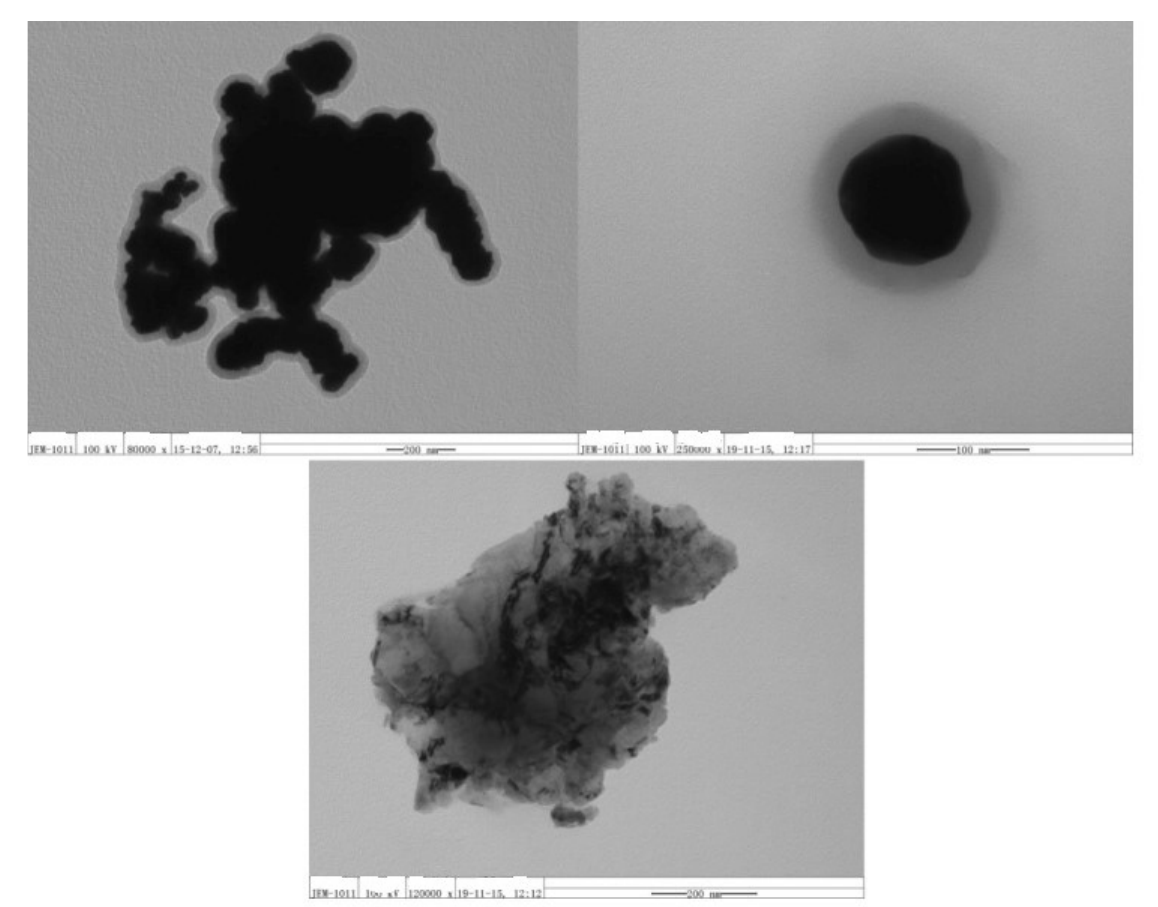
Figure 5. Representative TEM images of Au/PANi nanocomposite functionalized with beta- cyclodextrin with novel interface polymerization (Sample